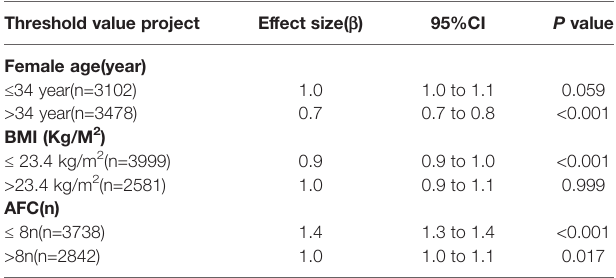
TABLE 3 | Threshold effect analysis of live birth using piece-wise linear regression. Threshold value project